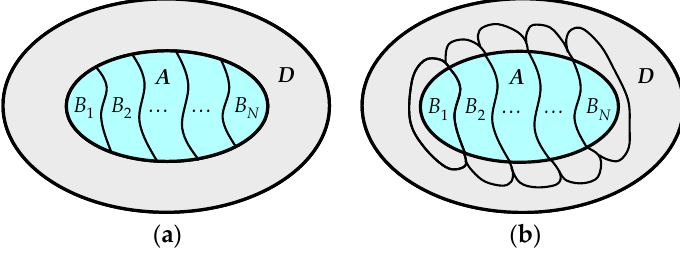
Figure 6. Reflection of system A by a collection of sets B 1 , B 2 , ... , B N : ( a ) System A is informationally closed; ( b ) system A is informationally open.